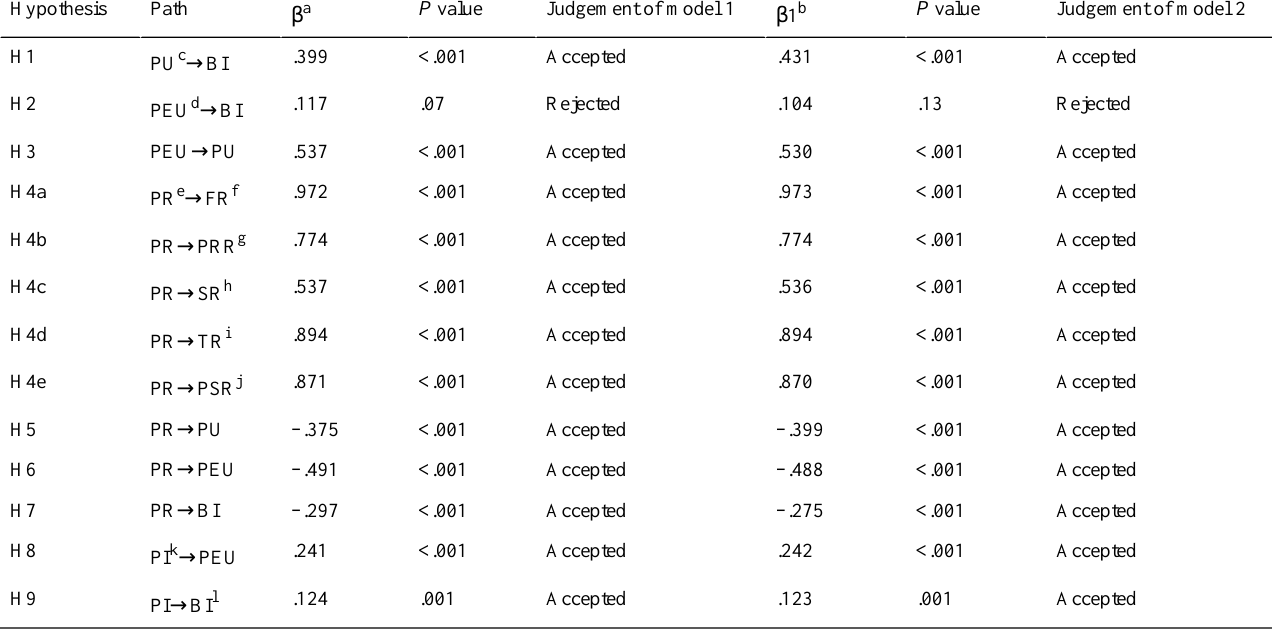
Table 5. Results of hypothesis